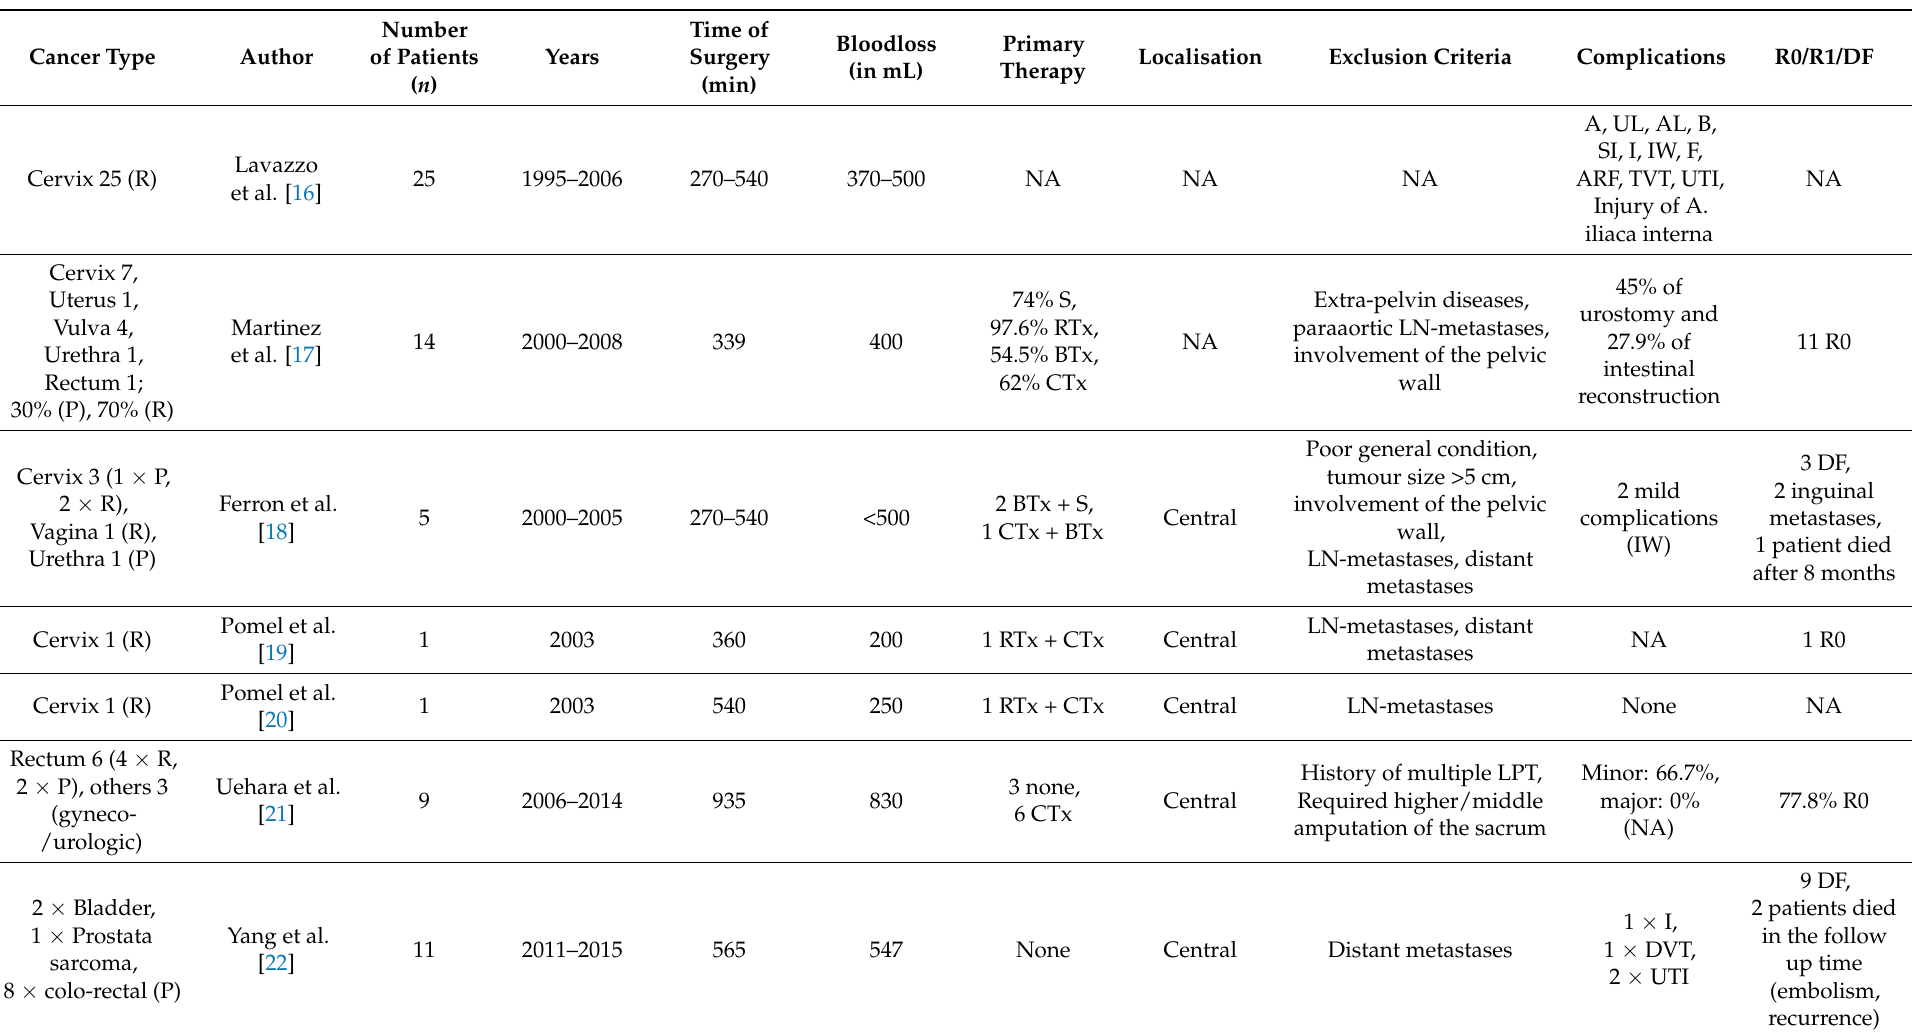
Table 1. Study details of laparoscopic